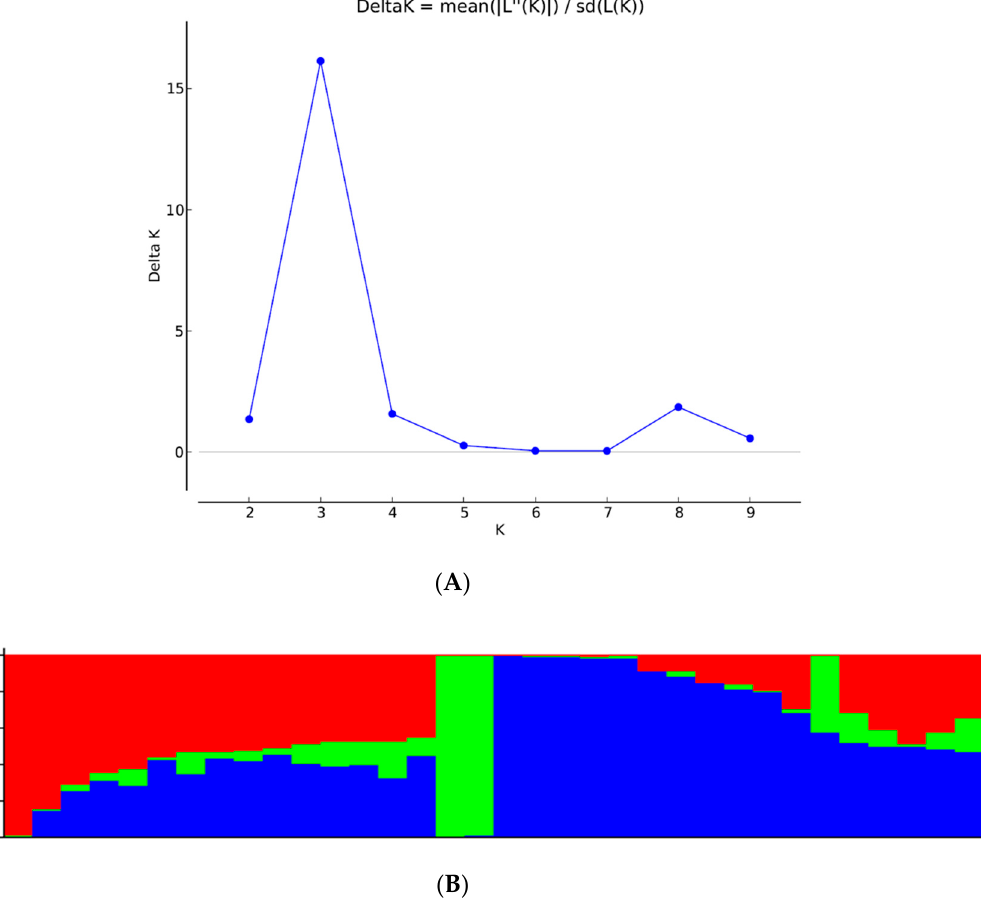
Figure 3. Population structure of the 34 inbred lines estimated using 4440 SNP markers. ( A ) Delta K for varying number of sub-populations from 1 to 10 and ( B ) estimated population structure of the 34 tropical inbred lines as revealed by 4440 SNP for K = 3. Red, green and blue colors indicate sub- population I, II and III, respectively. Individuals with the three colors and <70% of specific colour are considered as a mixture.